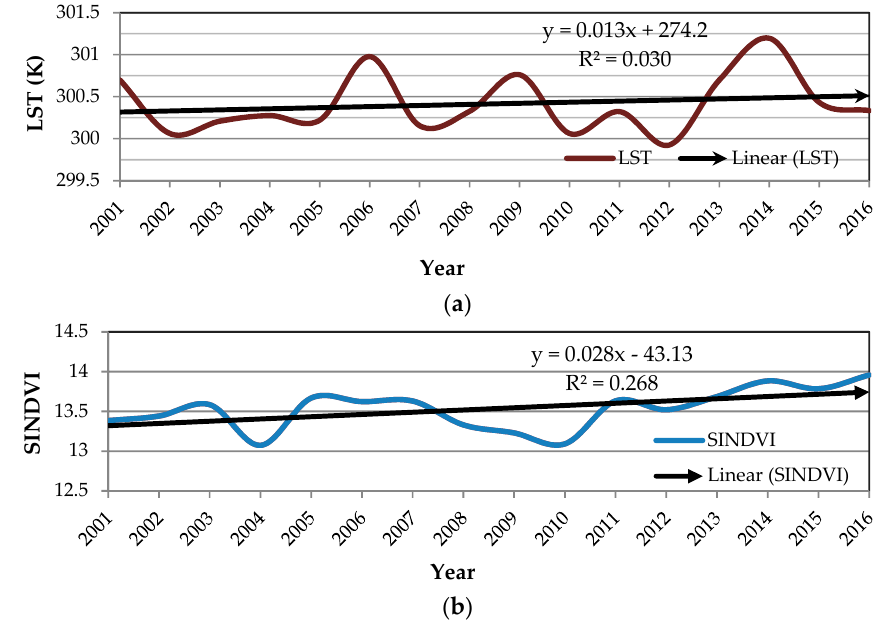
Figure 6. Interannual average ( a ) LST, and ( b ) SINDVI during 2001–2016 in the southeastern region of Bangladesh with linear variation trends.